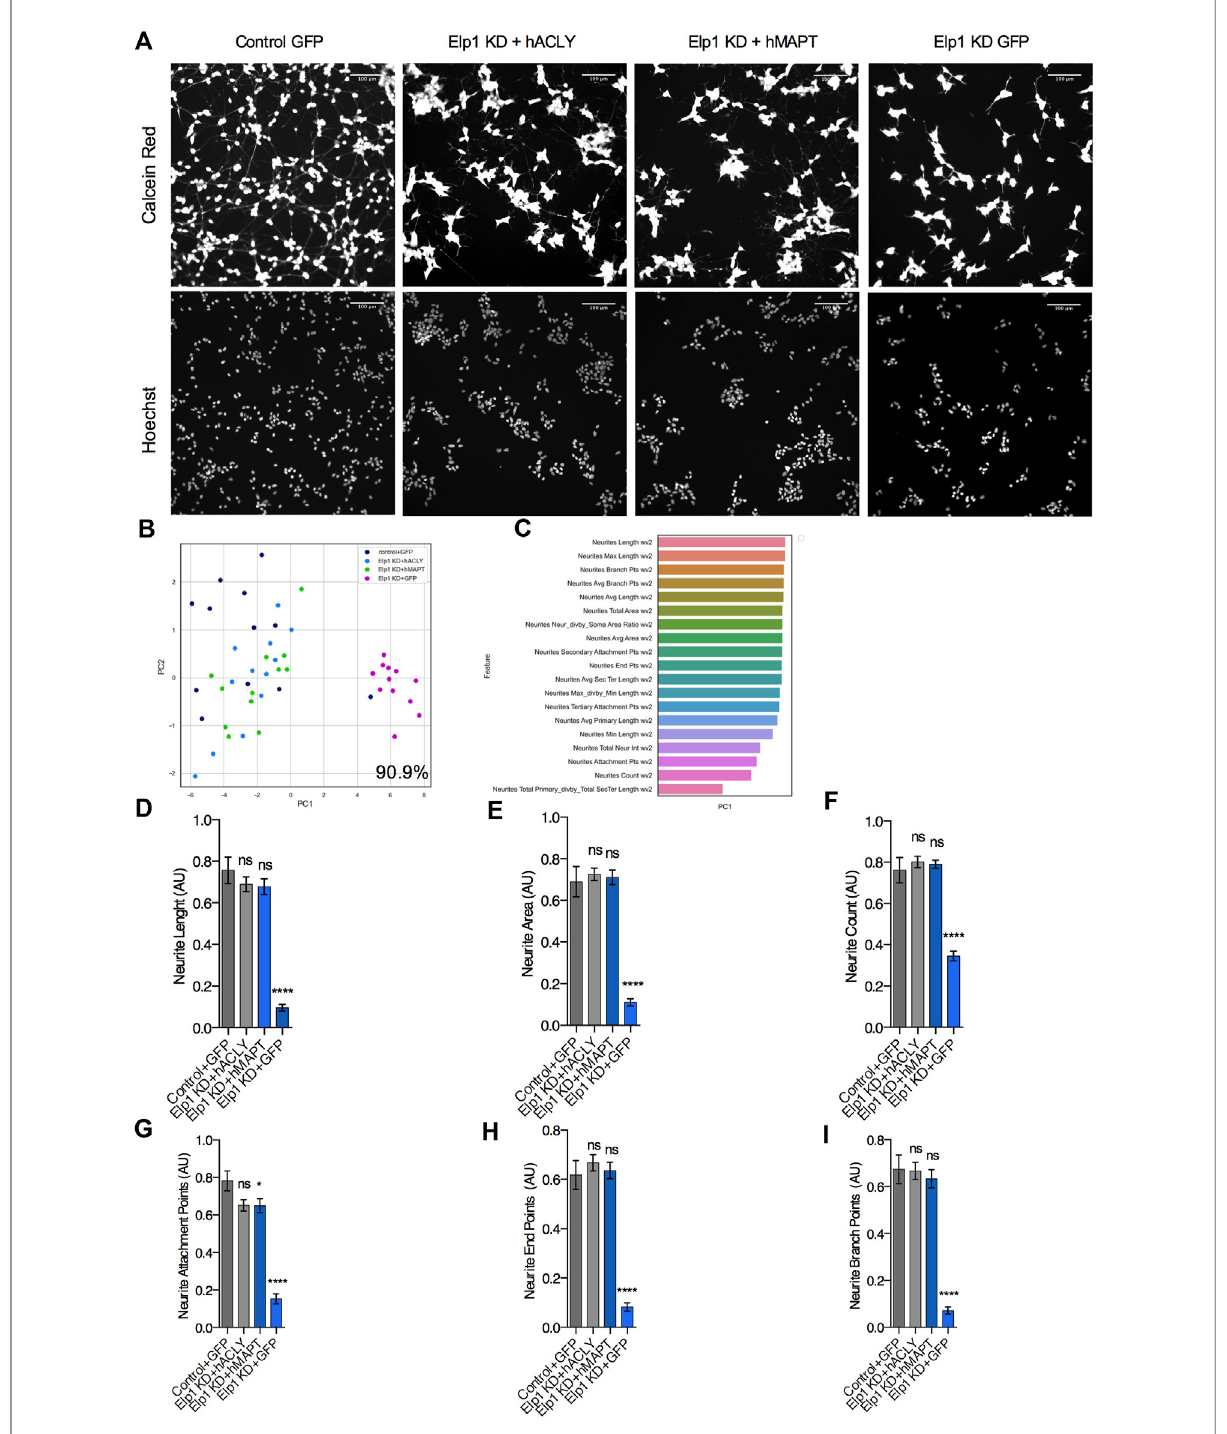
FIGURE 7 Expression of Acly or Tau rescues both Tau levels and neurites morphology defects in Elp1 KD cells. (A) Representative images of live fl uorescence microscopy of differentiated SHSY5Y cells transfected with control GFP or MAPT or ACLY expressing plasmids stained with both CalceinAM(Red)andHoechst(Blue);control(Control+GFP),Elp1KD(Elp1KD+GFP),Elp1KDexpressingTau(Elp1KD+hMAPT),Elp1KDexpressing acly (Elp1KD + hACLY) to visualize neurite morphology. Scale bar is 50 µm. (B) Two dimension principal component analysis (PCA) plot of stainedcellsbasedonmorphologicalfeatures.Symbolsrepresentthecontrolcells(darkblue);Elp1KD+hACLYcells(lightblue),Elp1KD+GFP(pink), Elp1KD + hMAPT (green). each circle represent data extracted from 20 fi elds coming from one well, each fi eld contain hundreds of cells. PCA Score